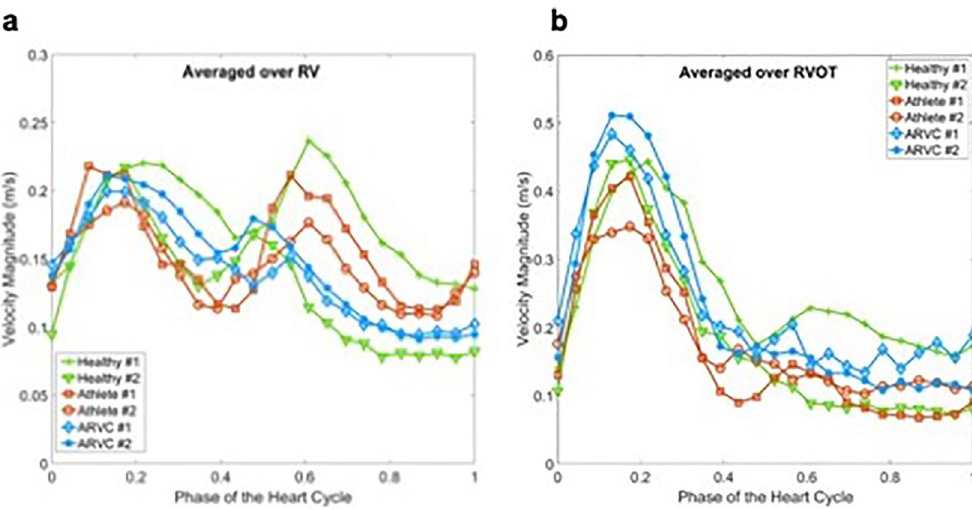
Figure 1. ( a ) Time evolution of velocity magnitude averaged over RV for healthy probands, athletes and patients with ARVC. ( b ) Time evolution of velocity magnitude averaged over RVOT for healthy probands, athletes and patients with